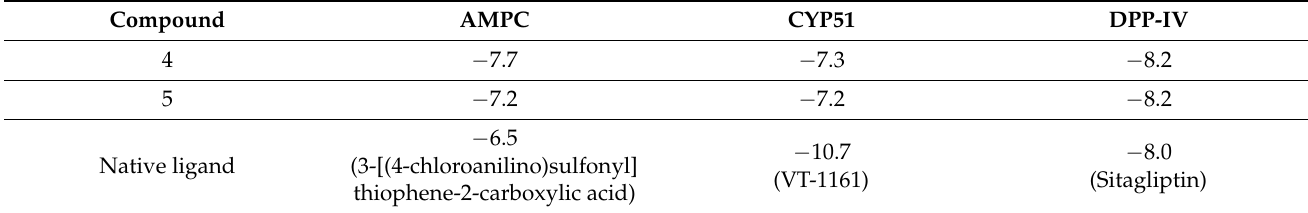
Table 5. AutodockVina’s flexible docking scores for docking runs of synthesized compounds 4 and 5 and native against each of the three targets AMPC, CYP51 and DPP-IV.